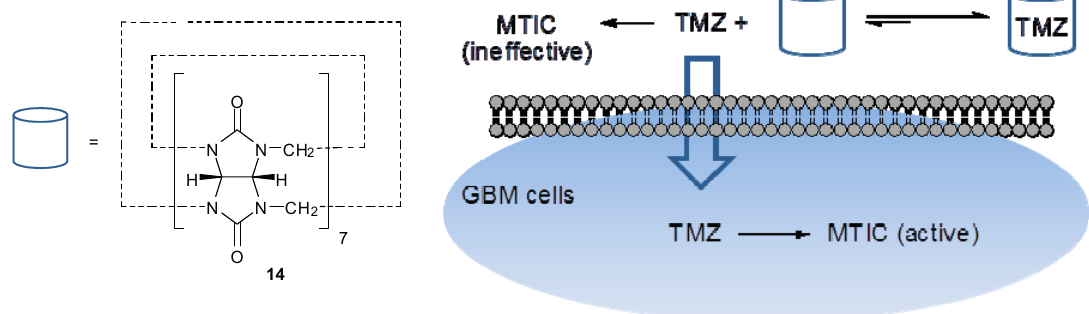
Figure 10. Cucurbit[ n ]uril ( 14 ) and uptake of TMZ into GBM cells